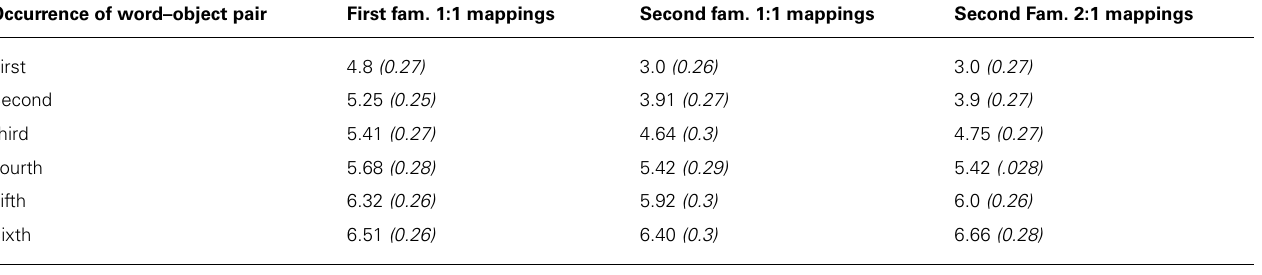
Table 2 | Means and SE (in parentheses) for confidence ratings by mapping type and occurrence of a word–object pair within a familiarization. Occurrence of word–object pair